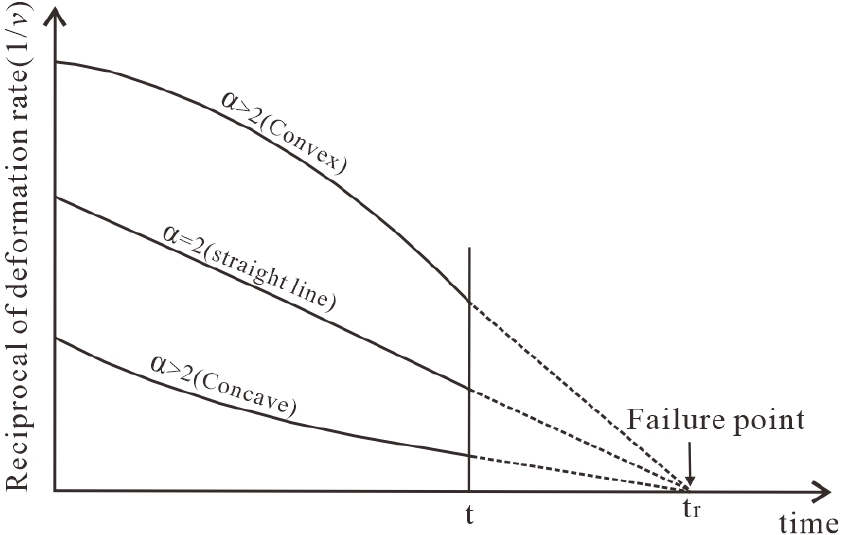
Figure 2. Plot of the INV model